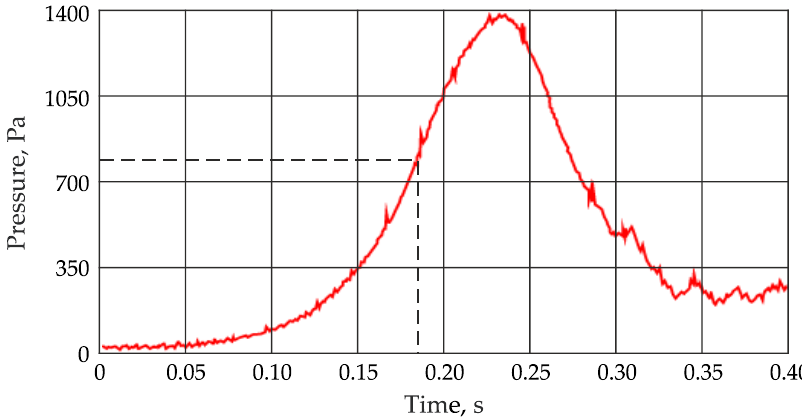
Figure 7. Experimental waveforms of excessive pressure when testing EVS #3 sample. Figure 8 provides instant photos of several moments of a deflagration explosion process inside the chamber involving shedding of an EVS installed in the relief opening.